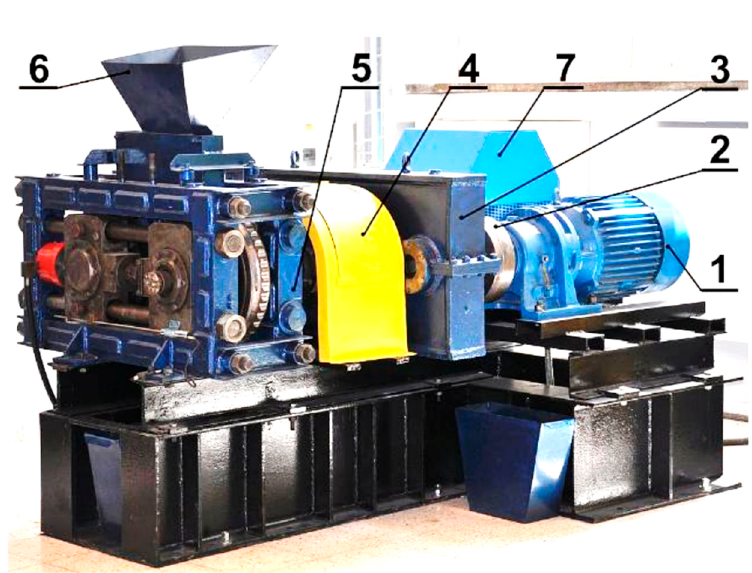
Figure 1. LPW 450 laboratory roller press: 1 —gear motor with a cycloidal transmission, 2 —flexible clutch, 3 —gearbox, 4 —enclosure of Oldham couplings and friction clutch, 5 —moulding rollers cage, 6 —gravity feeder, 7 —hydraulic system of sliding roller support.